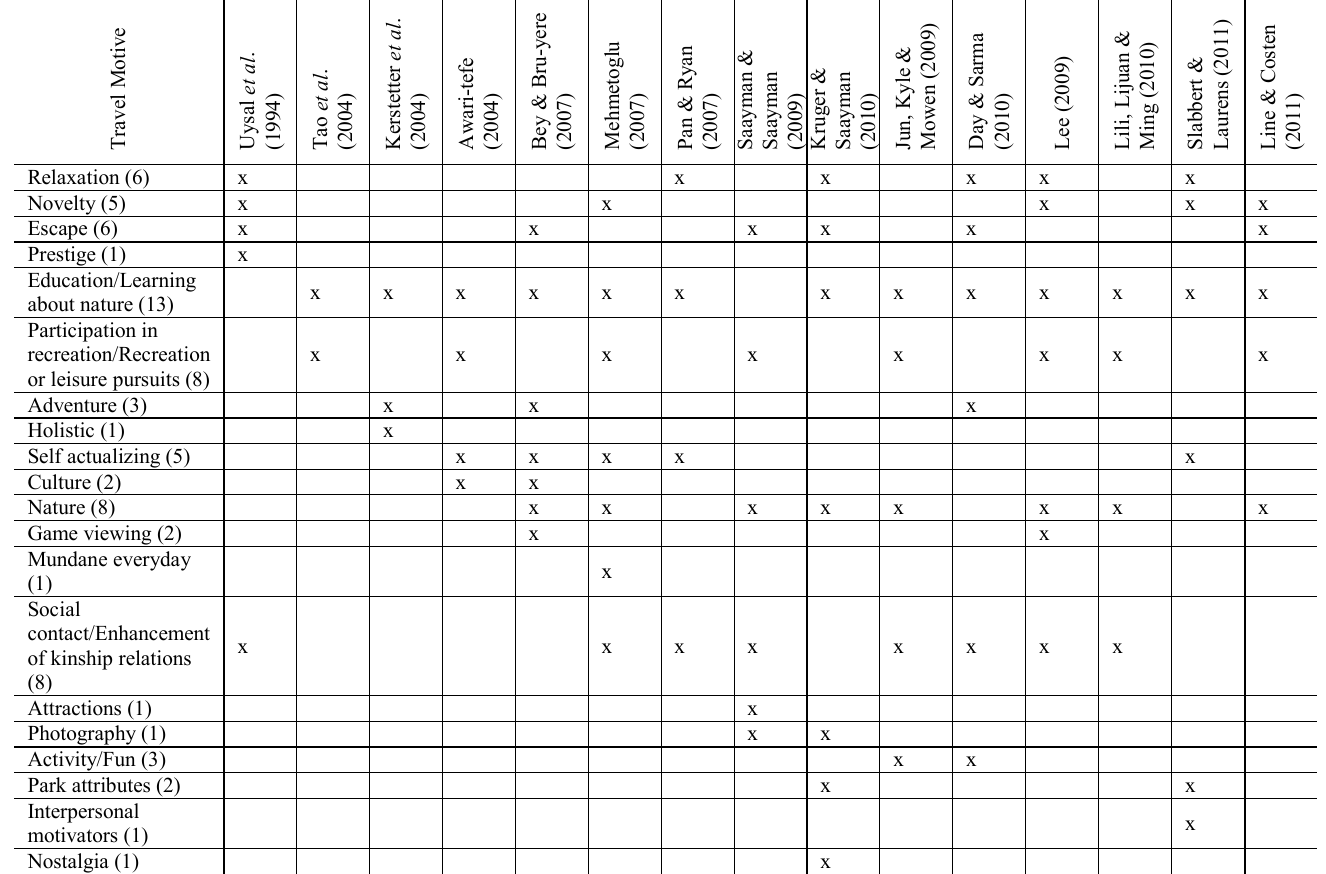
Table 1: Analysis of research on travel motives to National Parks/Nature